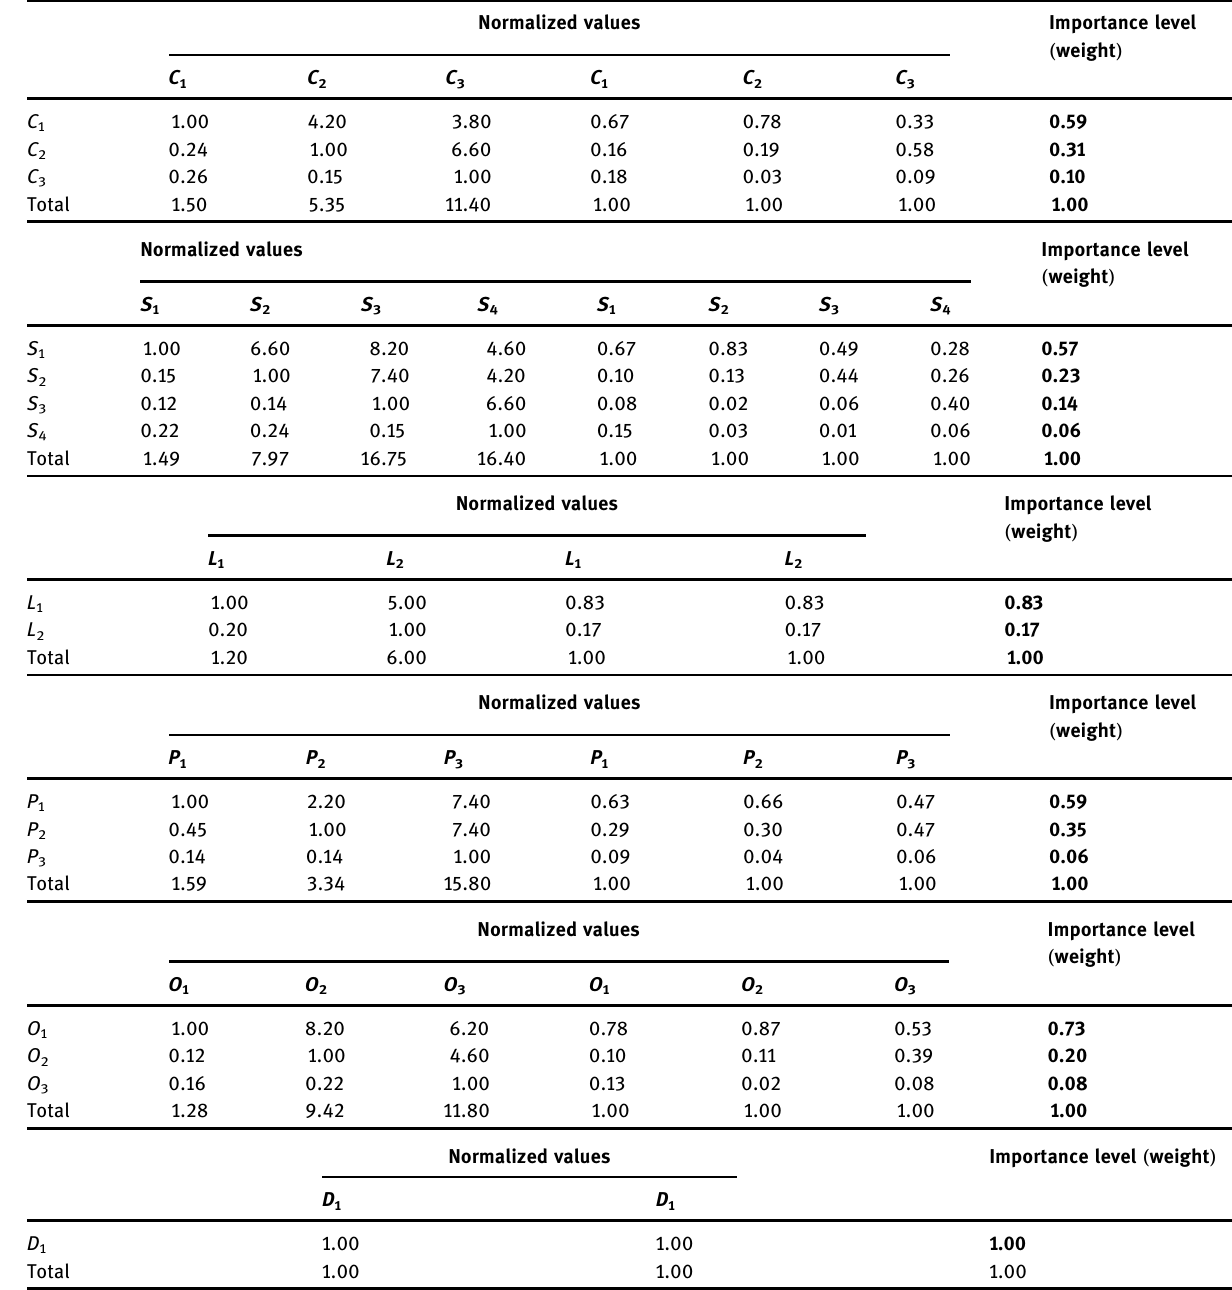
Bold values indicate the weights of importance for each